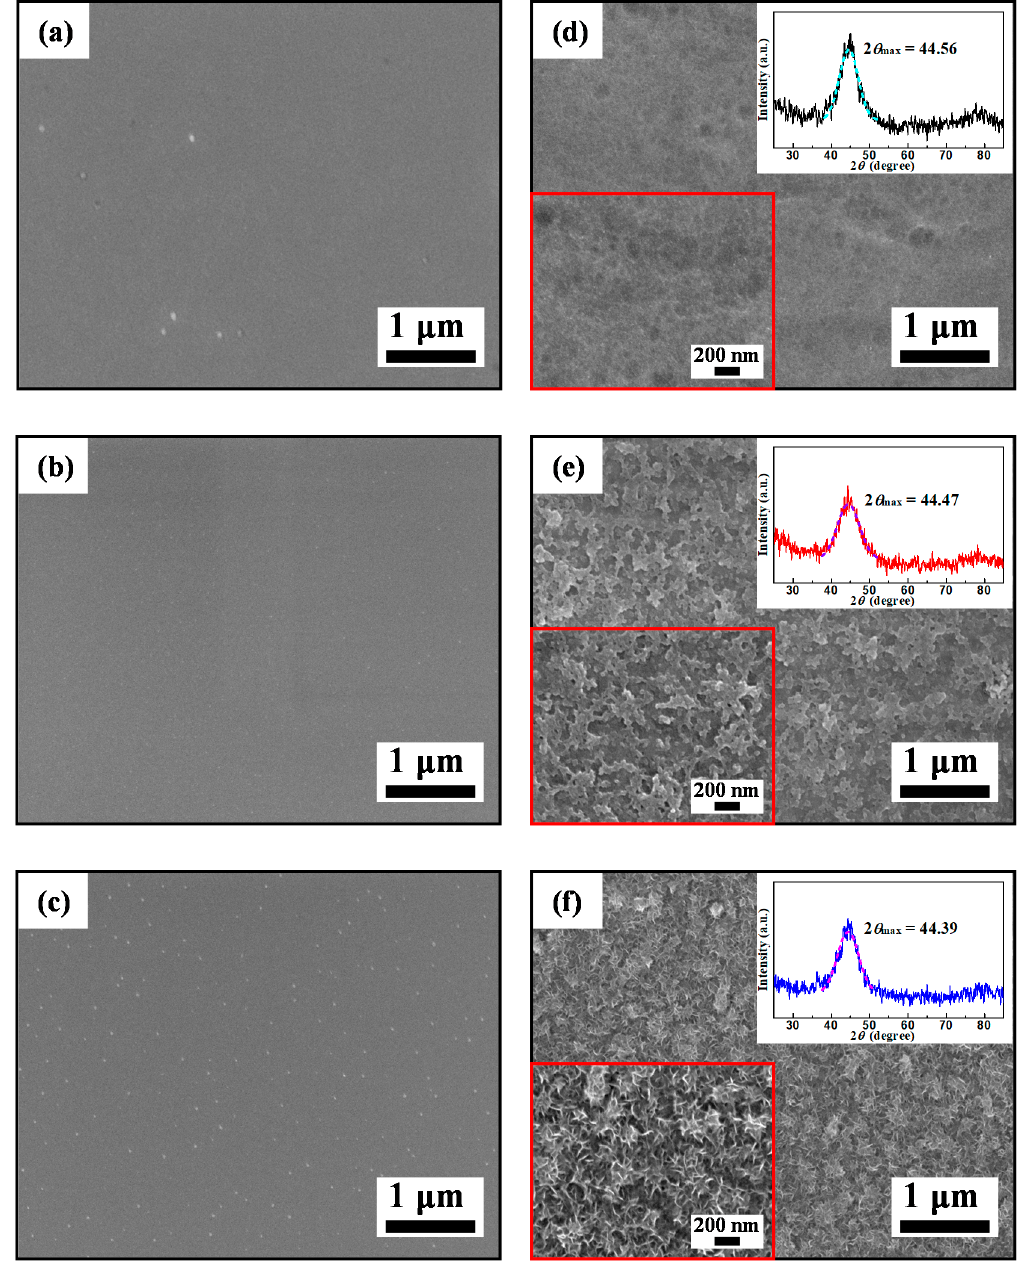
Figure 4. SEM micrographs of the as-spun ( a ) Zr0, ( b ) Zr0.5 and ( c ) Zr1 ribbons, and reacted ( d ) Zr0, ( e ) Zr0.5 and ( f ) Zr1 ribbons The insets in ( d – f ): the high-magnification images and XRD patterns of reacted Zr0, Zr0.5 and Zr1 ribbons. Table 1. Energy dispersive X-ray spectrometer (EDS) analysis of the Zr0, Zr0.5 and Zr1 ribbons before and after reacted (at.%).